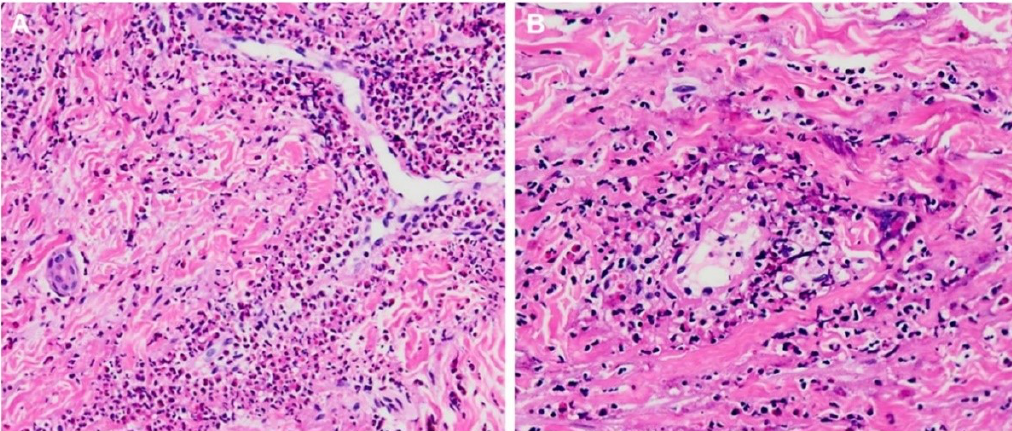
Figure 1. Histopathological findings of tissue eosinophilia and vasculitis changes in skin biopsy specimens from case no. 1. ( A ) Interstitial infiltration of abundant eosinophils in the dermis. Hematoxylin and eosin stain 100×. ( B ) Necrotizing vasculitis in a small vessel with marked infiltration of eosinophils in the vessel wall. Hematoxylin and eosin stain 200×.